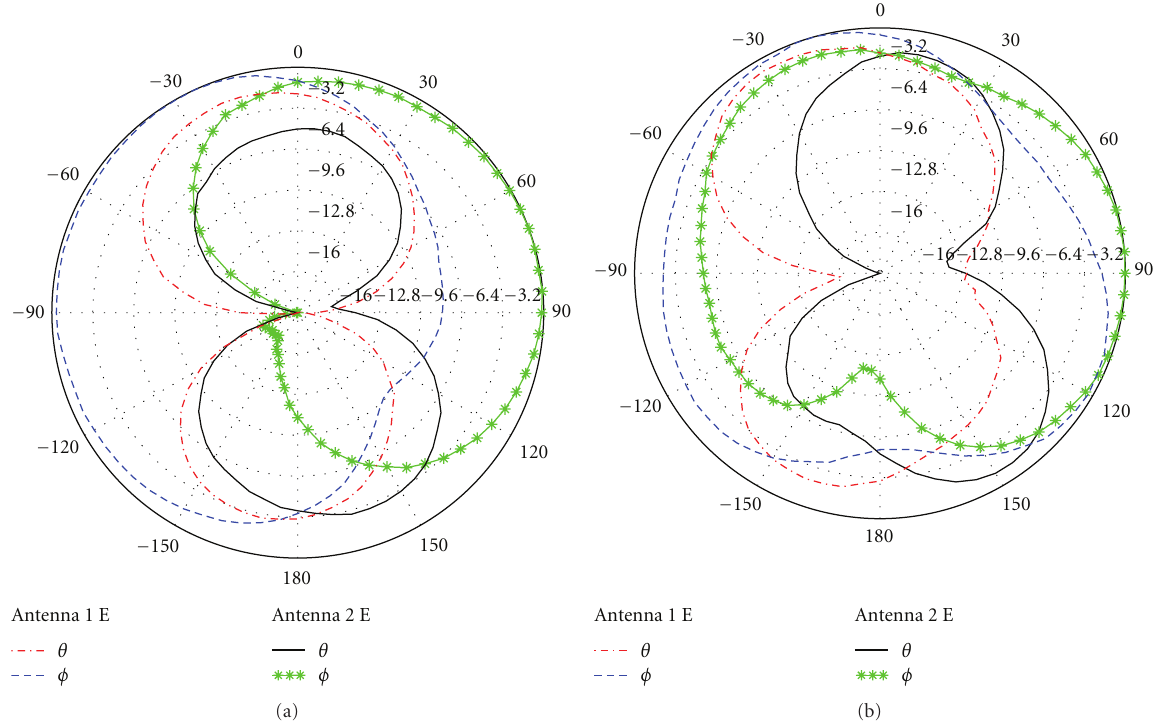
Figure 8: Measured radiation pattern at 0.9GHz. (a) The yoz plane. (b) The xoz plane.